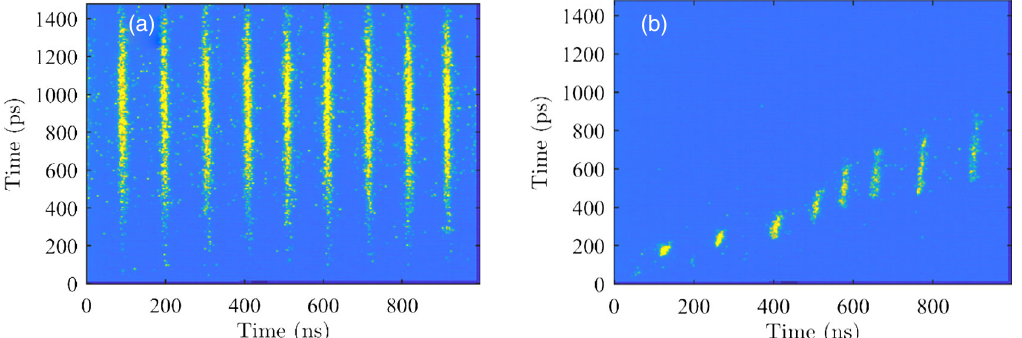
FIG. 10. (a) Dual sweep streak camera image (single frame, 14th after injection trigger) with an equilibrium bunch length of ∼ 300 ps at 0.5 nC with both rf systems powered on for 375 MeVand (b) dual sweep streak image (first single frame at injection) on the PAR OSR showing the elongation of the bunch over successive turns and the change in arrival time right after initial injection with both rf systems off. The horizontal axis with 1 - μ s time range also has some spatial information in a dispersive location at the source where the injection transient shifts the position of the equally spaced turns in time to reflect that spatial transient [27]. A 1 - μ s long MCP gate timed with the horizontal sweep was used for both